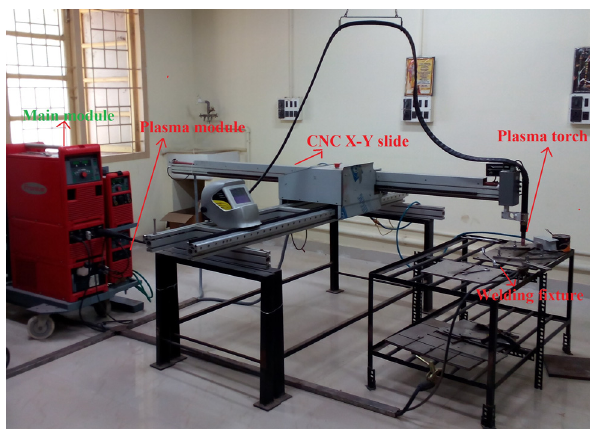
Figure 2: Schematic diagram showing the experimental setup used for PAW.